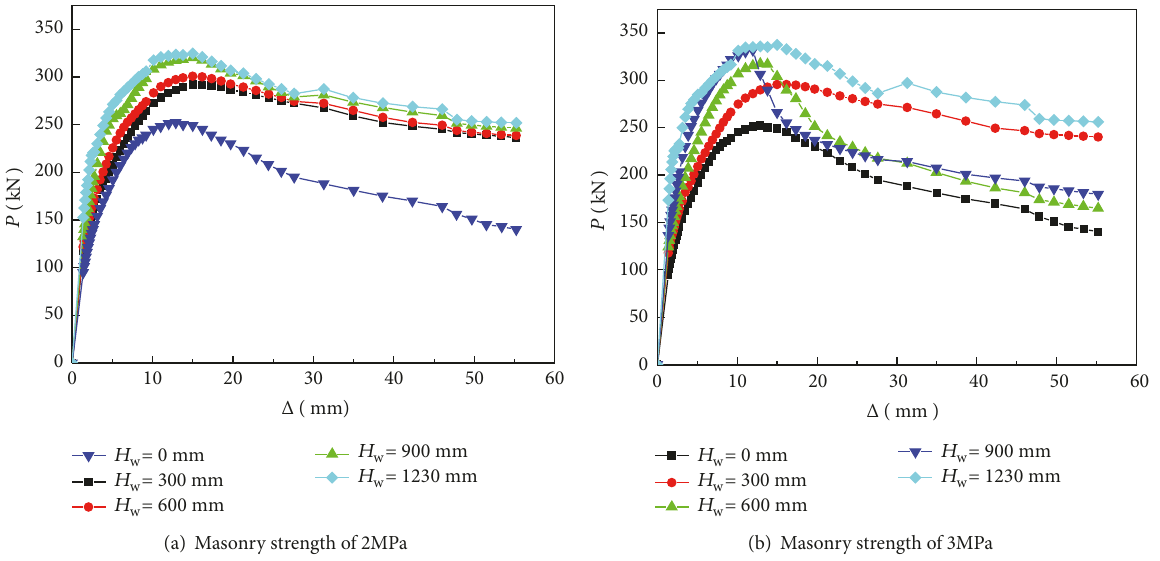
Figure 18: Load-displacement